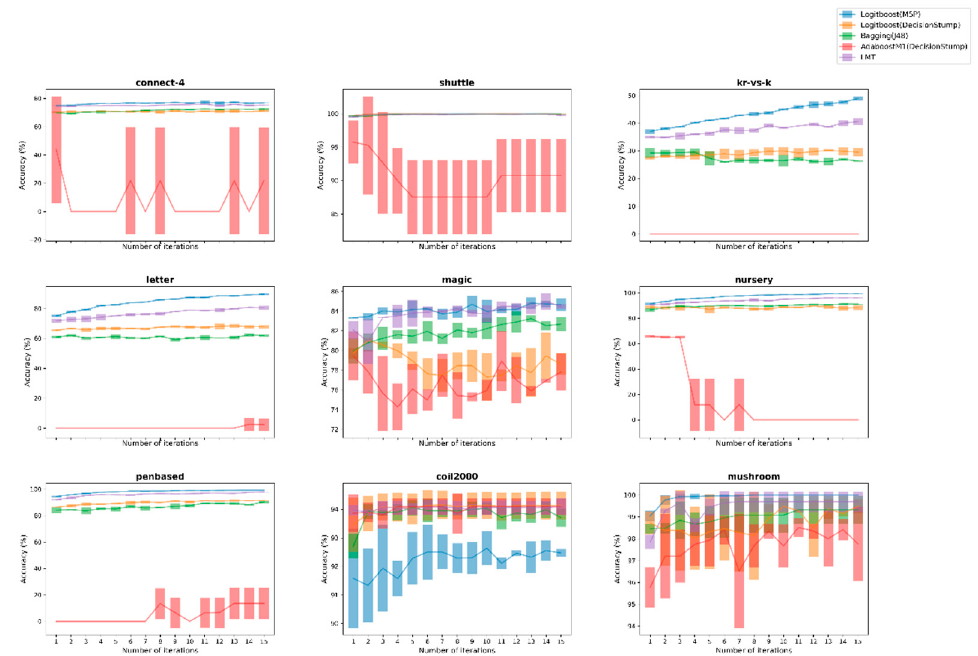
Figure 4. Comparison of the proposed Logitboost(M5P) against 4 ensemble learners over the 9 larger datasets between both binary and multi-class ones for UncS(SMar) with R = 5%.